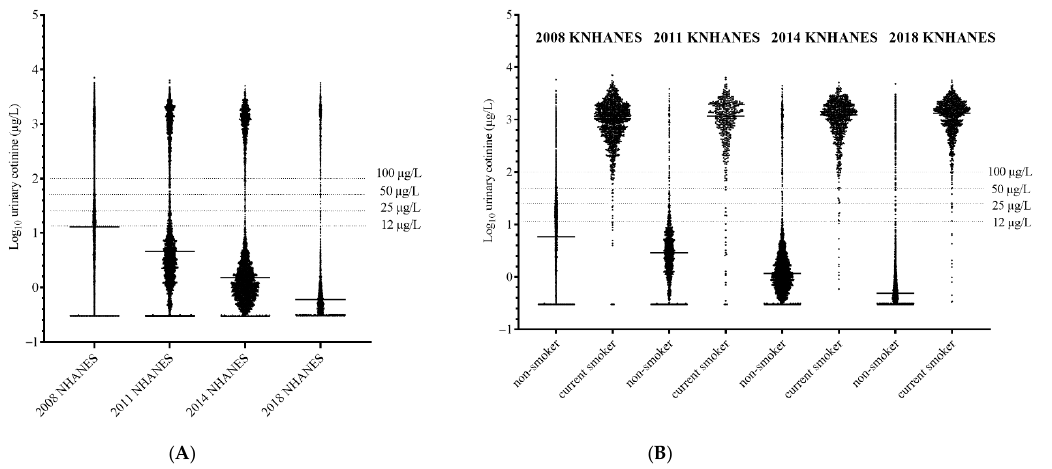
Figure 4. The comparison for distribution of urinary cotinine concentration in total enrolled partic- ipants ( A ) and according to smoking status classification ( B ) between 2008 and 2018 KNHANES datasets. The horizontal dotted lines represent the various cut-off values of urinary cotinine concen- tration for distinguishing current smokers from nonsmokers. The horizontal solid lines represent the median urinary cotinine values in each population. KNHANES = Korean National Health and Nutrition Examination Survey. According to a visual inspection of the scatter plot of urinary cotinine concentration, the distribution patterns in current smokers were relatively similar among the four da- tasets. Most current smokers showed values greater than 100 µg/L of urinary cotinine, and only 2.0% (20/1047, in 2018) to 2.9% (13/457, in 2011) of current smokers showed values ranging from 12 µg/L to 100 µg/L in all datasets (Table 7). However, the distribution of nonsmokers showed a markedly decreased pattern during the recent decade. The percent